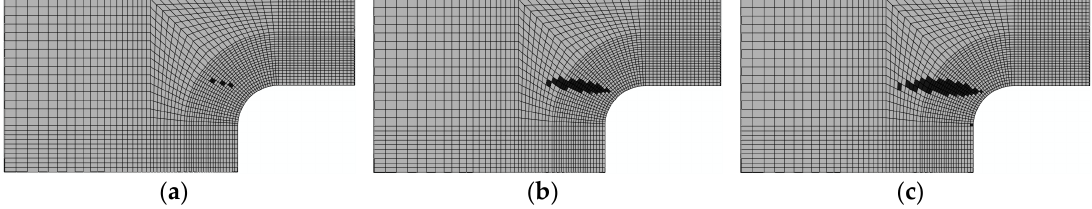
Figure 13. Matrix fracture damage of unrepaired fiber caused by transverse tension or shear ( − 45°): ( a ) 118.1 kN; ( b ) 166.2 kN; and ( c ) 192.3 kN.